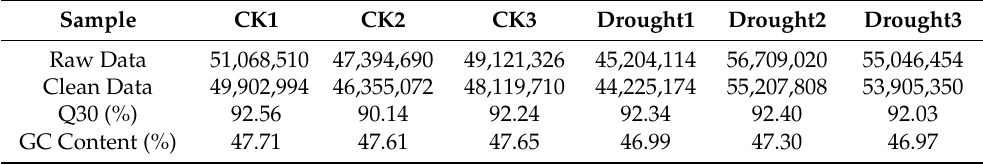
Figure 2. The photosynthetic characteristics of B. striata under normal and drought conditions: ( A ) net photosynthetic rate ( P n), ( B ) stomatal conductance ( G s), ( C ) intercellular CO 2 concentration ( C i), ( D ) evaporation rate ( E ), ( E ) stomatal limitation ( L s), and ( F ) ratio of C i/ G s. Means and standard errors of at least five replicates are shown. Table 1. Summary of transcriptomes in B. striata under drought